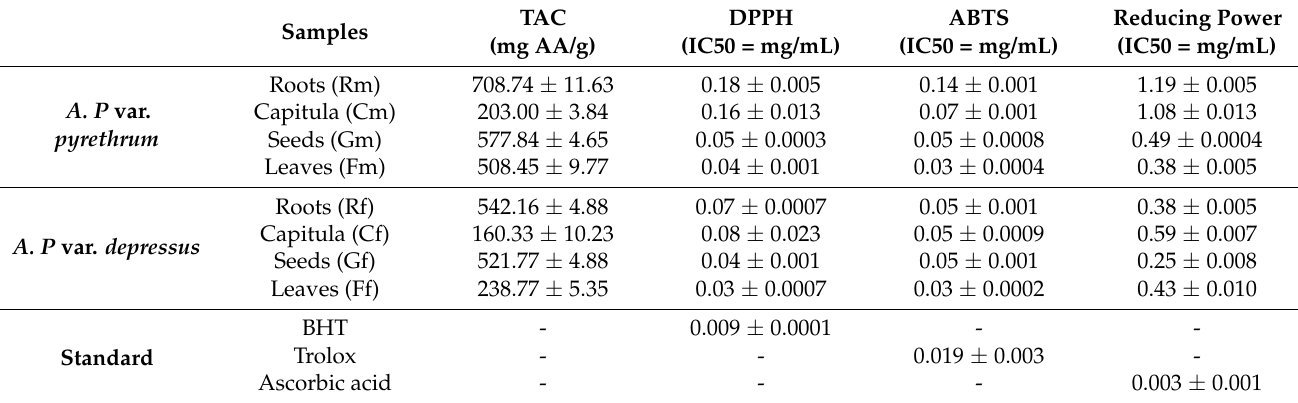
Table 5. The antioxidant activities (DPPH (2,2-diphenyl-1-picrylhydrazyl), ABTS (2,2-azino-bis 3-ethylbenzothiazolin-6- sulfonic acid), FRAP(ferric reducing antioxidant power), and TAC (total antioxidant capacity)) of different extracts